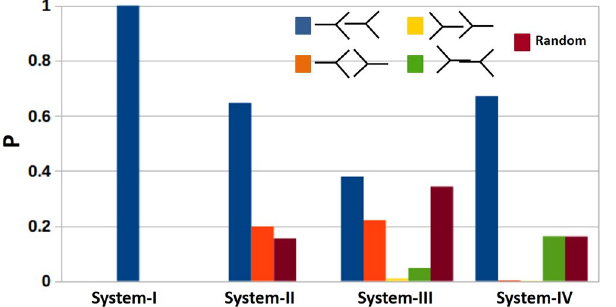
Figure 5. Probability distributions of the orientations of TG N –TG C pairs in all CG systems from simulation data. Color code: BLUE: “parallel N-N”, ORANGE: “antiparallel N-C”, YELLOW: “parallel C-C”, GREEN: “antiparallel C-N”, BROWN: random orientations of TG pairs bound to